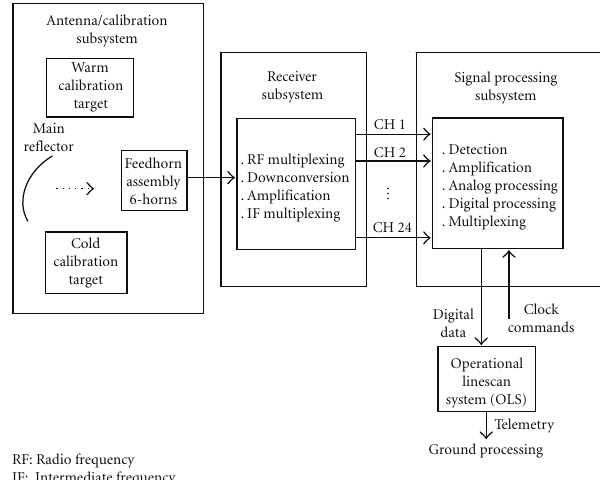
Figure 1: SSMIS simplified block diagram [2].